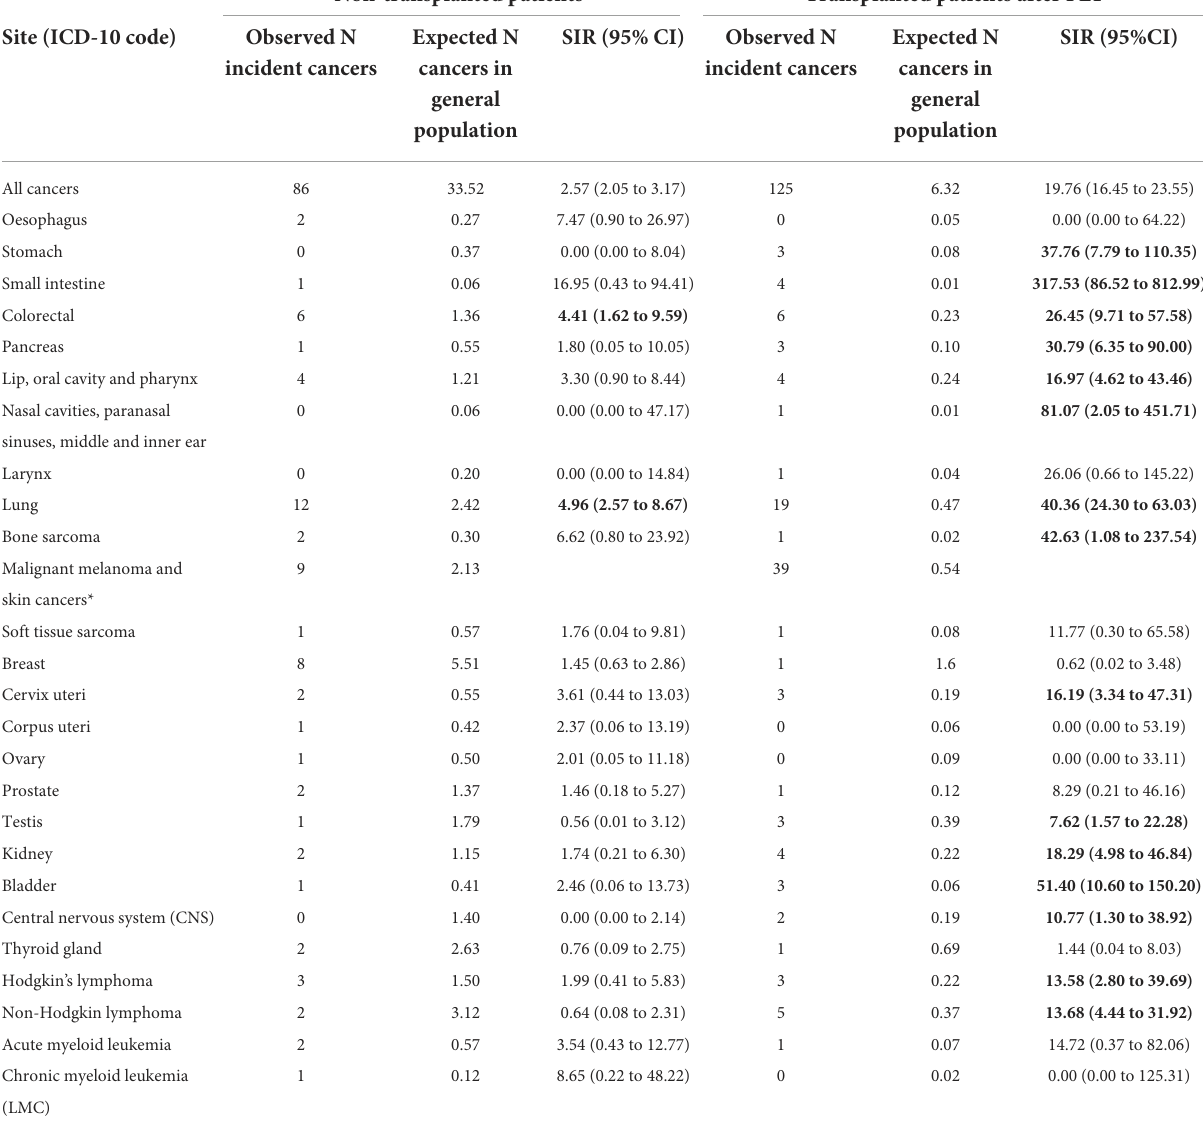
TABLE 3 Observed and expected numbers of cancers and SIRs among non-transplanted and PLT patients with CF in France from 2006 to 2017. Non-transplanted patients Transplanted patients after